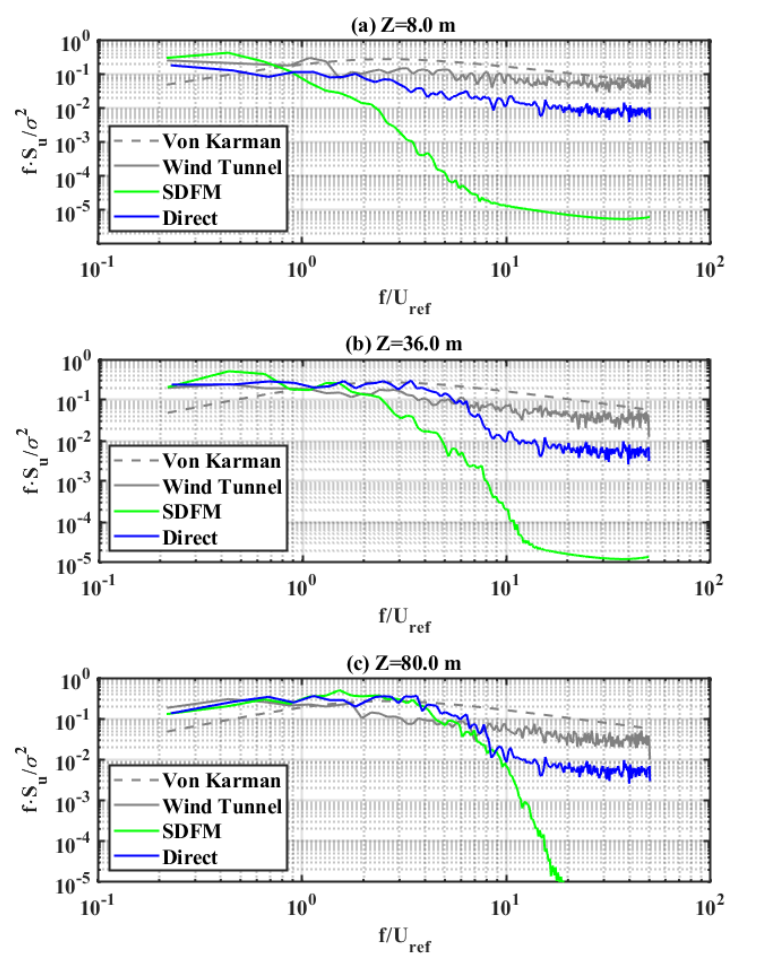
Figure 9. Spectrum of longitudinal velocity from von Karman, experiments, SDFM, and direct methods for ( a ) 8.0 m, ( b ) 36.0 m, and ( c ) 80.0 m height at